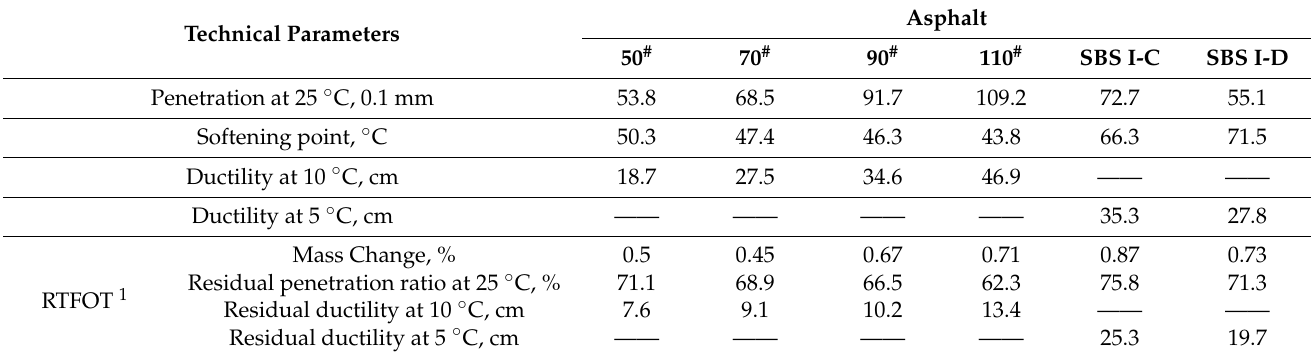
Table 1. Technical parameters of asphalt used in this paper.